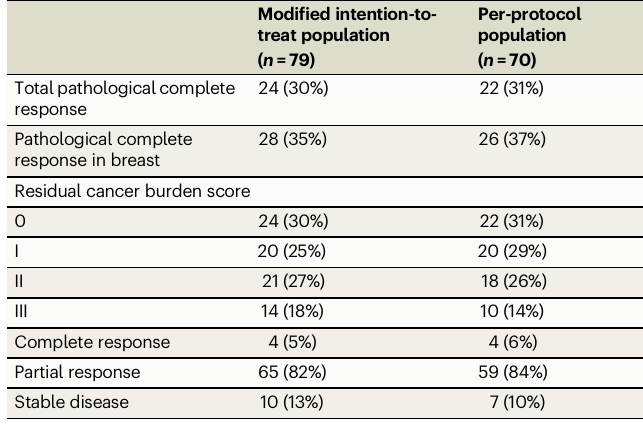
Table 1 | Baseline and disease characteristics of patients